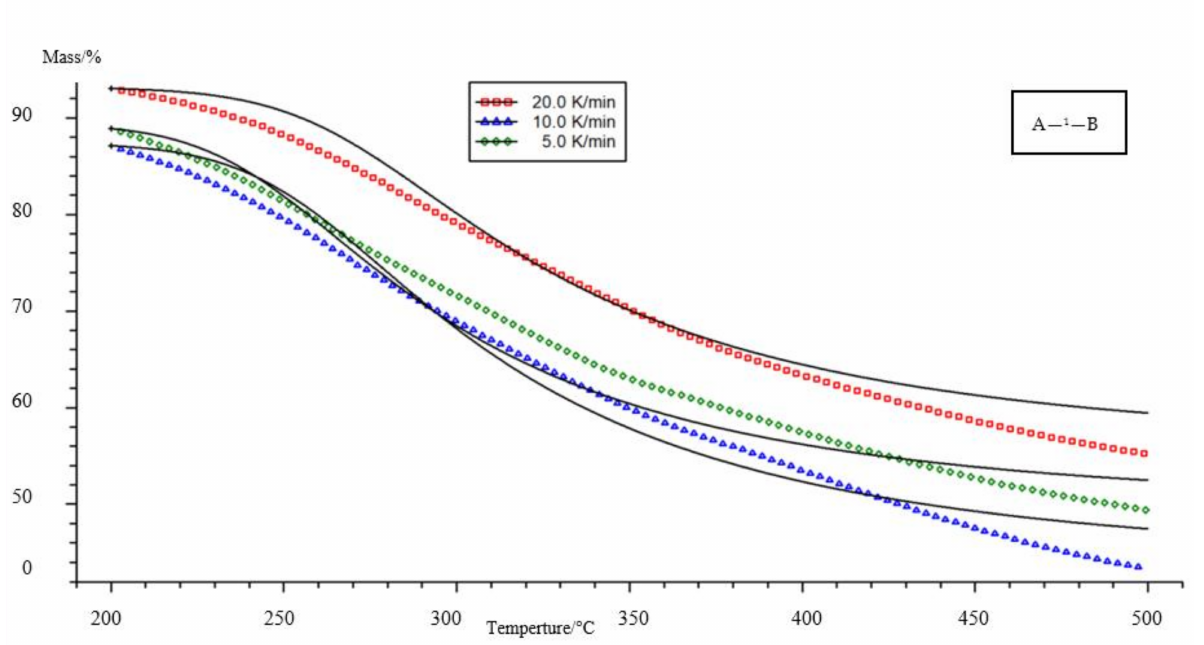
Figure 16. Fitting the calculated kinetic model for sewage sludge to the experimental data. It should be noted that the calculated triplet (n, E a , ln A) represents just the optimal physical meaning (reaction order). This method of calculating activation energy is obvious: